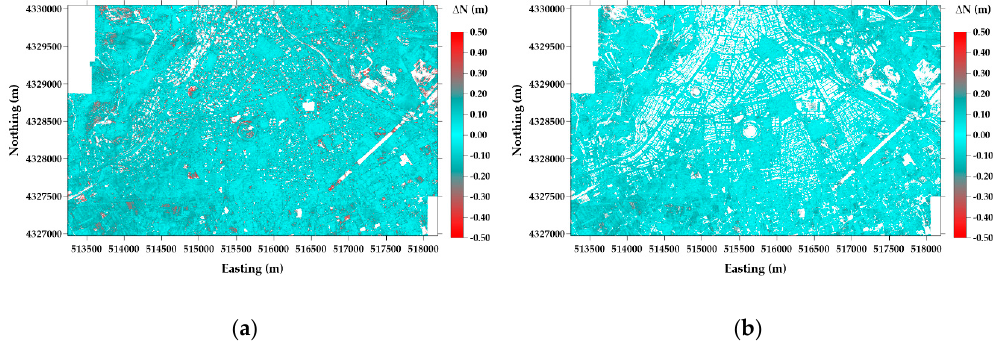
Figure 14. Differences between calculated local geoids and TG03 regional geoid surfaces with ( a ) Envi LiDAR; ( b ) Global Mapper. Table 4. Statistics of geoid height differences between local geoid models (Envi LiDAR and Global Mapper, respectively) and regional Turkey Geoid (TG03) (m).